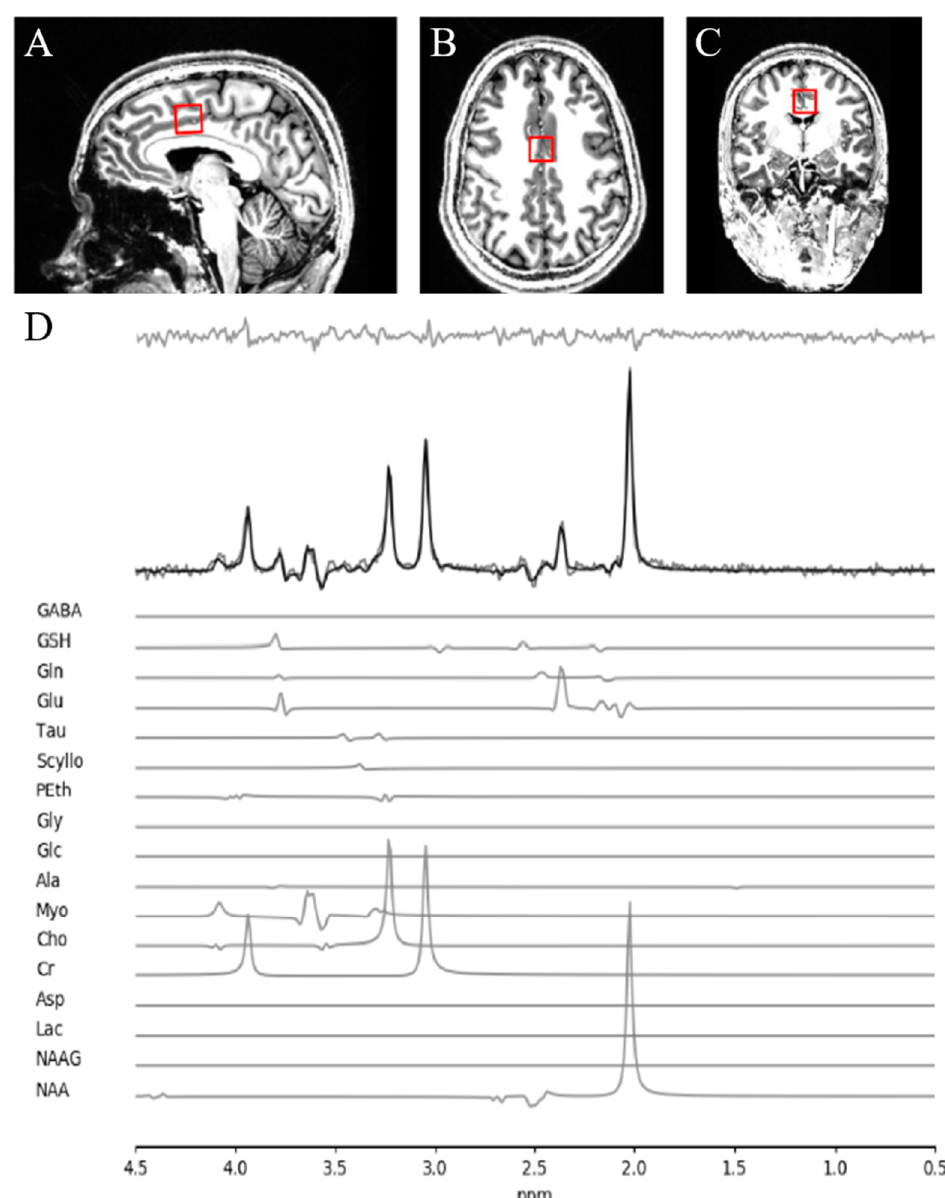
Figure 1. MRS voxel and spectra. ( A ) Sagittal, ( B ) axial and ( C ) coronal views of voxel positioning on the dorsal anterior cingulate cortex. ( D ) Sample spectra obtained from a single healthy participant. The bolded black line represents the fitted spectra with the residuals above and each individual metabolite contributions below.